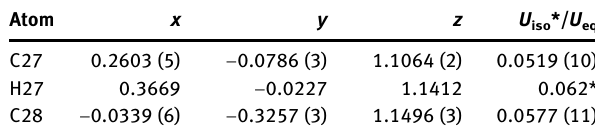
Both O -alkylation and N -alkylation of 2-pyridone are both an important molecular scaffold for their biological and pharmaceutical properties [6 – 8]. However, based on the Hard – Soft Acid – Base theory, the softer nitrogen atom will tends to bond the softer carbon atom than oxygen. And, the N -alkylation compound is more thermodynamic stable than O -alkylation. Thus, there are a large amount of methods for the N -alkylation for of 2-pyridone moiety, but the absolute selective synthesis of O-alkylation is even rarer. We have reported the syntheses and the structures of some related compounds [5, 9, 10]. Single crystal structure analysis reveals that the title compound crystallizes in the triclinic P-1 space group with two crystallographically independent molecules in the asymmetric unit (see the Figure). All bond lengths and angles are in the expected ranges. Every molecule contains of a substituted phenyl benzene ring and a pyridinyl ring, and the dihedral angles between the two planes are 21.1